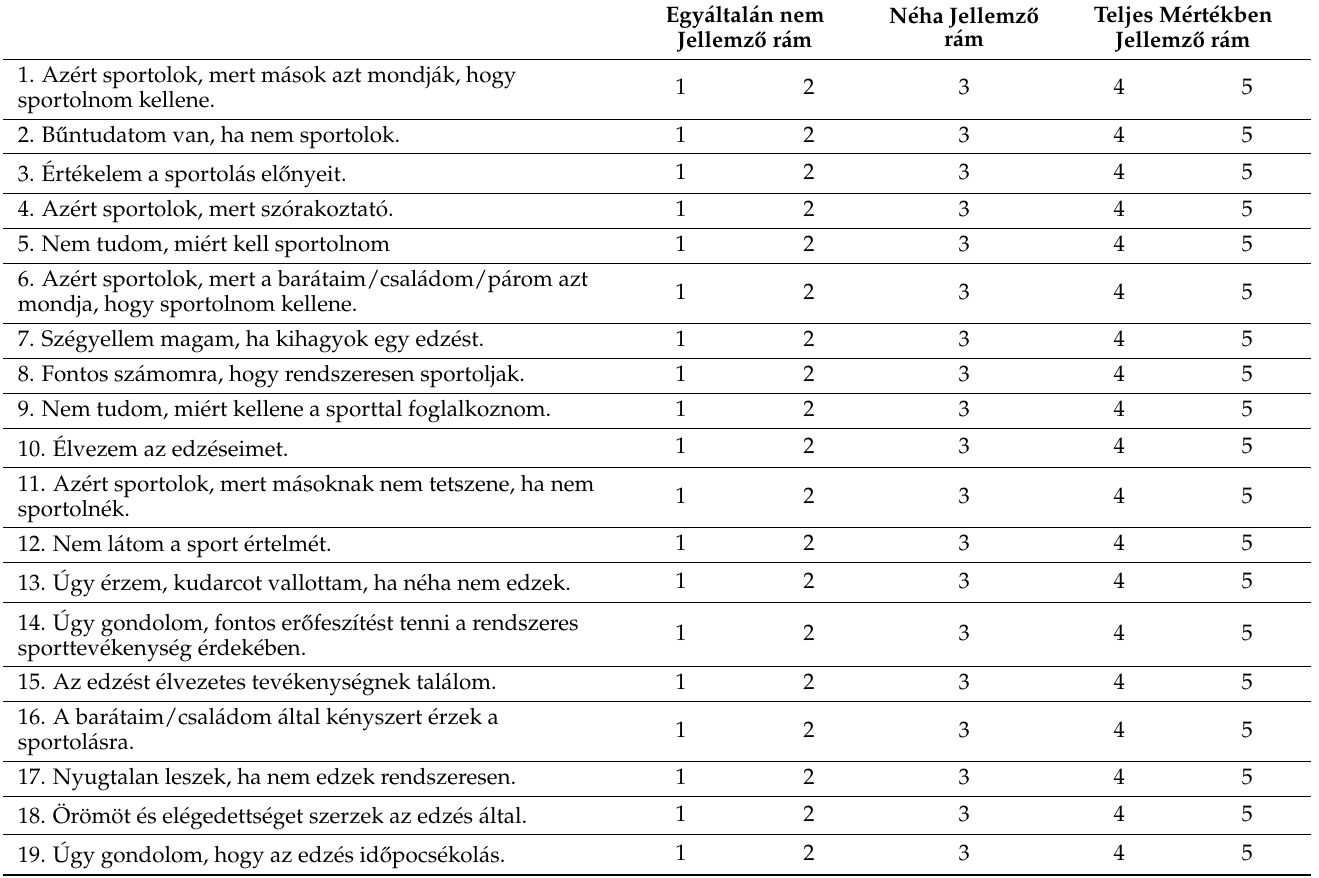
Table A1. The Hungarian version of the